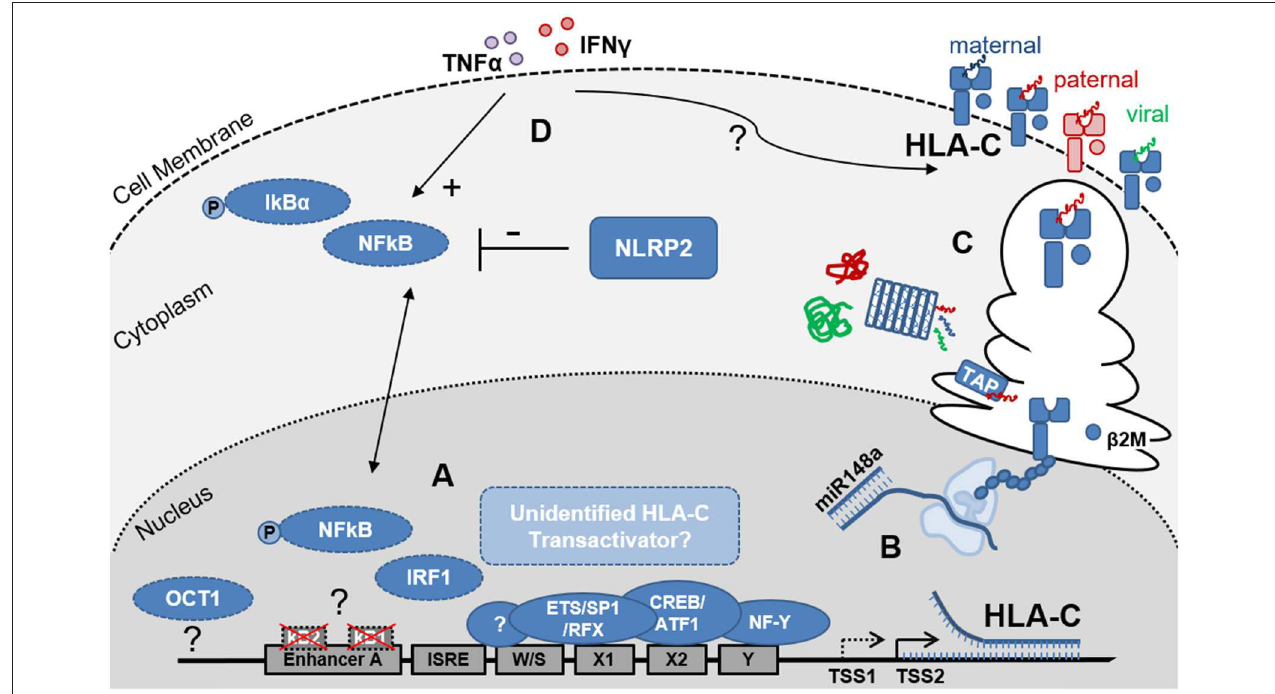
FIGURE 1 | Schematic representation of the factors that influence HLA-C expression levels on EVT. (A) Depicts the key elements of the HLA-C promoter region and enhanceosome. Differences between the HLA-C and HLA-A/B promoter regions include the non-functional κ B1- and κ B2-NF κ B binding sites in Enhancer A and the putative OCT1 binding site 800kb upstream of the HLA-C core promoter. EVT do not express the MHC Trans Activators NLRC5 and CIITA, suggesting additional but currently unidentified factors may contribute to regulation of HLA-C transcription. Furthermore, trophoblast specific transcription start sites (TSS) may be present and influence HLA-C mRNA length and stability; (B) Post-transcriptional regulation includes the binding of miR148a to the 3 ′ UTR of the mRNAs of several HLA-C allotypes resulting in reduced HLA-C expression levels; (C) Post-translational events including peptide processing by the immunoproteasome and ER-resident Aminopeptidase 1 and 2 (ERAP) as well as peptide loading, by the peptide loading complex (PLC), which is comprised—amongst other subunits- of tapasin and the peptide transporters TAP1 and 2, influence HLA-C protein stability and HLA-C surface expression levels; Allogeneic peptides of paternal origin are depicted in red, maternal peptides in blue and pathogen-derived peptides in green; (D) Proinflammatory cytokines including IFN È (red) and TNF α (purple) influence HLA-C expression levels through NF κ B dependent and independent pathways. Additionally, NOD-like receptors (NLRs) including NLRP2, which is highly expressed by EVT, influence cytokine induced NF κ B activation and HLA-C